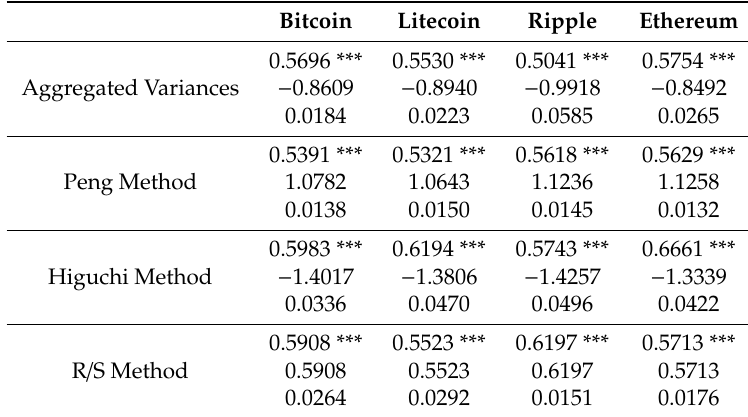
Table 1. Hurst exponent